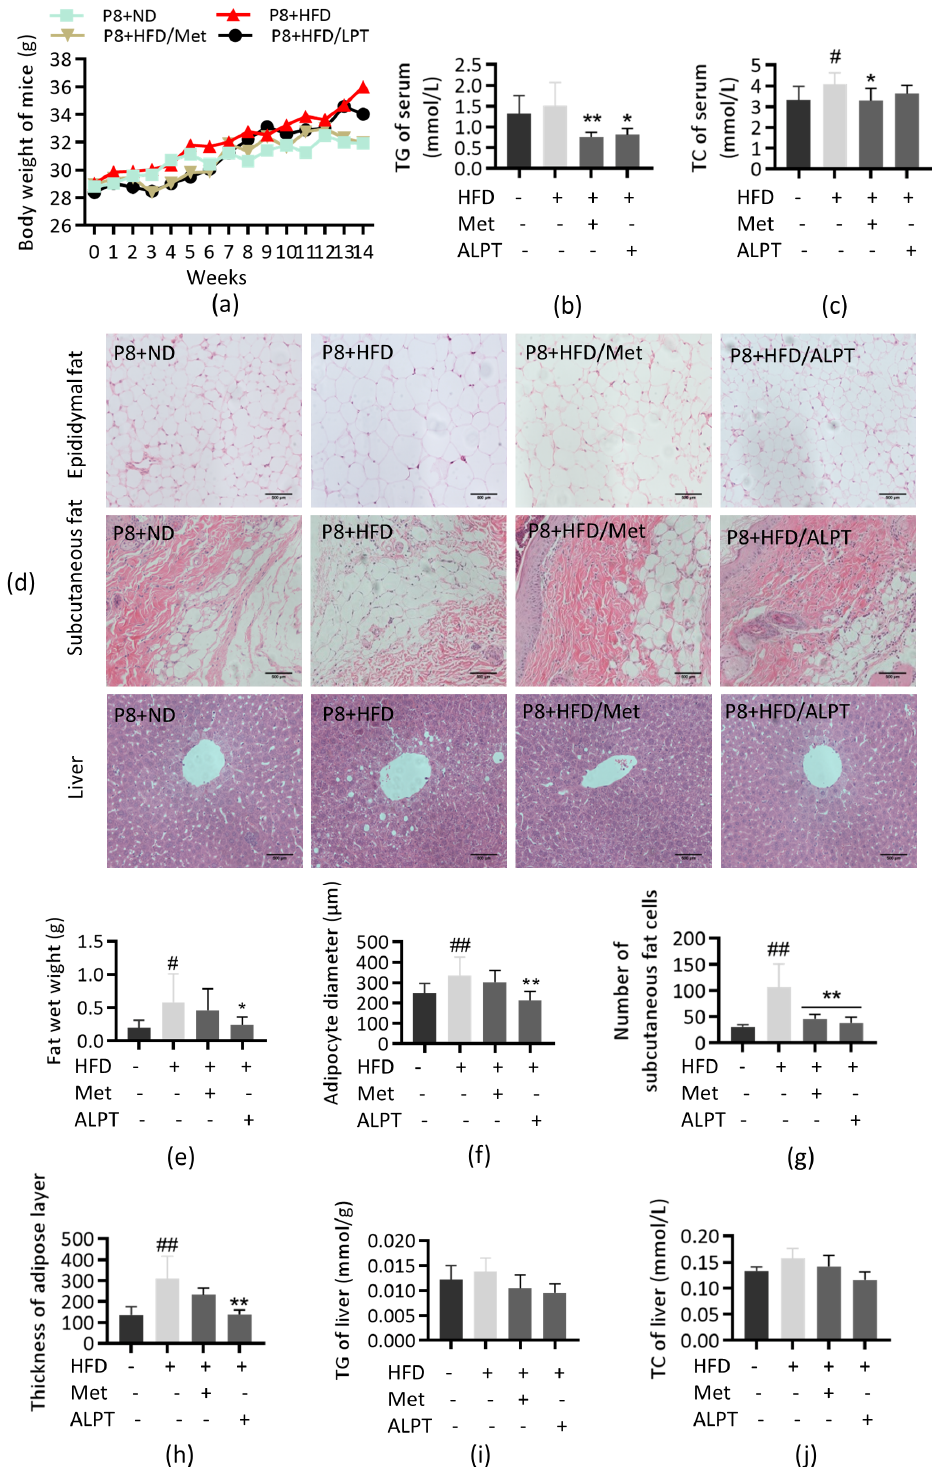
Figure 2. ALPT improved lipid metabolism in high-fat diet SAMP8 mice. ( a ) A body weight measurement of mice in different treatment groups, n = 10; ( b , c ) determination of serum triglyceride (TG) and total cholesterol (TC) content, n = 10; ( d ) HE staining of epididymal fat, skin and liver (200 × ); ( e , f ) wet weight and cell diameter of epididymal fat, n = 5; ( g , h ) measurement of the thickness of the subcutaneous fat layer, n = 5; ( i , j ) liver TG and TC content test, n = 5. # represents compared with P8+ND group, p < 0.05, ## represents compared with P8+ND group, p < 0.01, * represents compared with P8+HFD group, p < 0.05, ** represents compared with P8+HFD group, p <